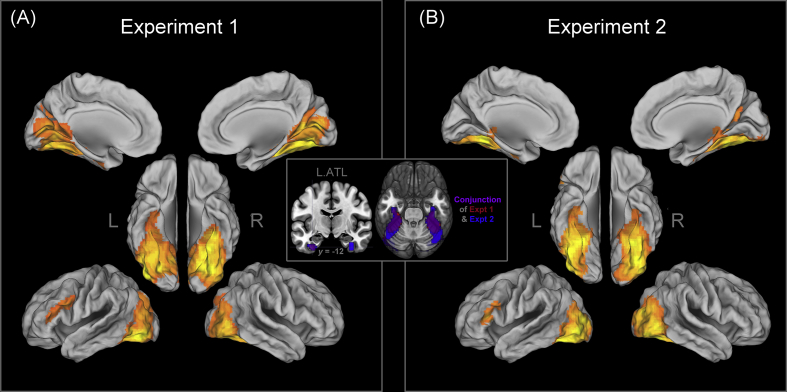
Whole-brain analysis identified regions activated by object recognition, contrasting against scrambled-pattern control tasks (A: Expriment 1; B: Experiment 2). The thresholds were set at p < 0.001 at the voxel level and p < 0.05 (FWE-corrected for multiple comparisons) at the cluster level. The middle inset-box reveals that a shared ‘hub’ region at the left ATL was commonly engaged by the two experiments (the purple-shaded area).